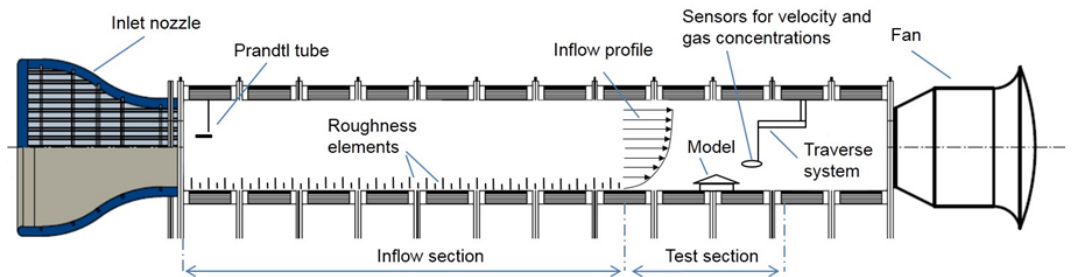
Figure 1. Wind tunnel description; in our setup, the model is the porous stone material described in Section 2.1.2.